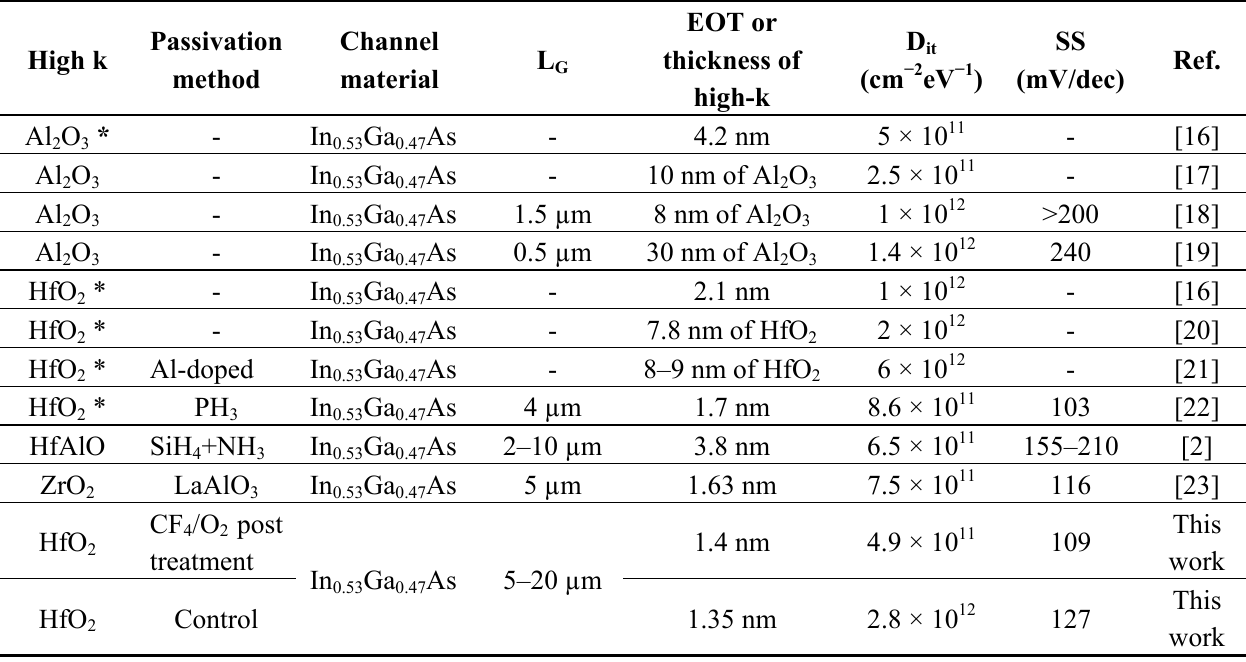
Table 1. Comparison of the electrical and interfacial properties of this work with some recently reported